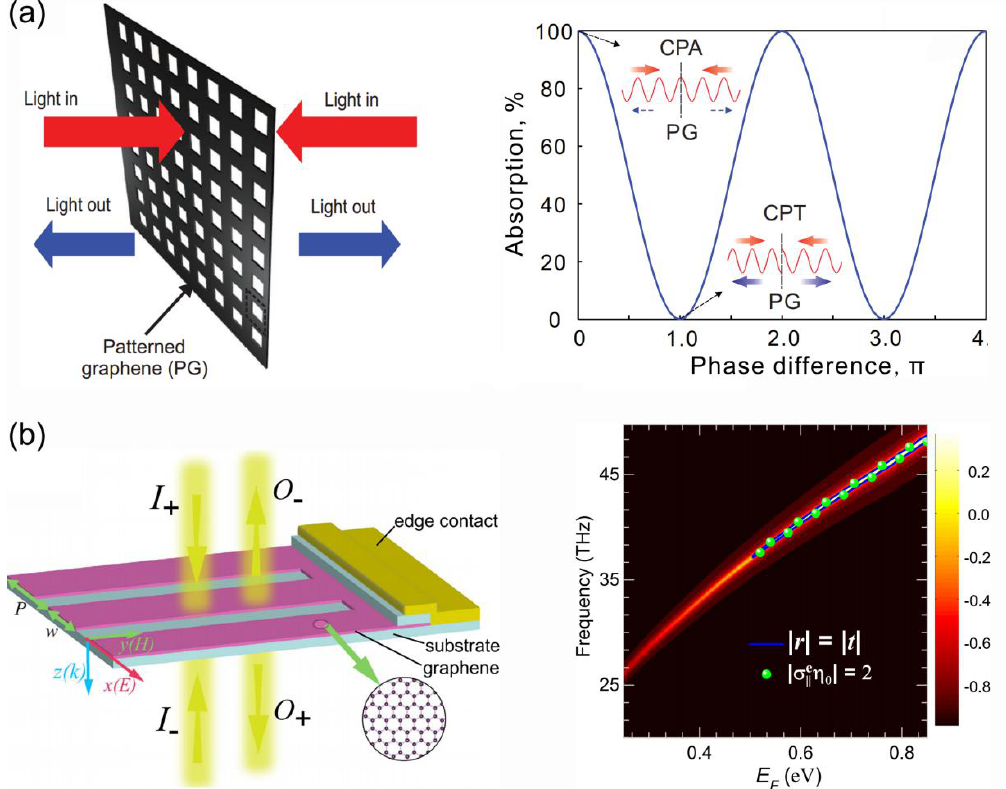
Figure 5 Figure 5. ( a ) Schematic illustration of coherent absorption in a nanostructured graphene, accompanied by the phase modulation of coherent absorption at the resonance wavelength of 8.476 µ m [25]. ( b ) Left: schematic of a graphene ribbon meta-surface illustrated by two counter propagating and coherently modulated input beams. Right: The difference ( | r | − | t | ) of the scattering coefficients for the graphene meta-surface as functions of frequency and Fermi energy E F , the solid blue line indicates quasi-CPA points where | r | = | t | [126]. Reproduced from references [25,126], with permission from Optical Society of America, 2014; with permission from Nature Publishing Group,